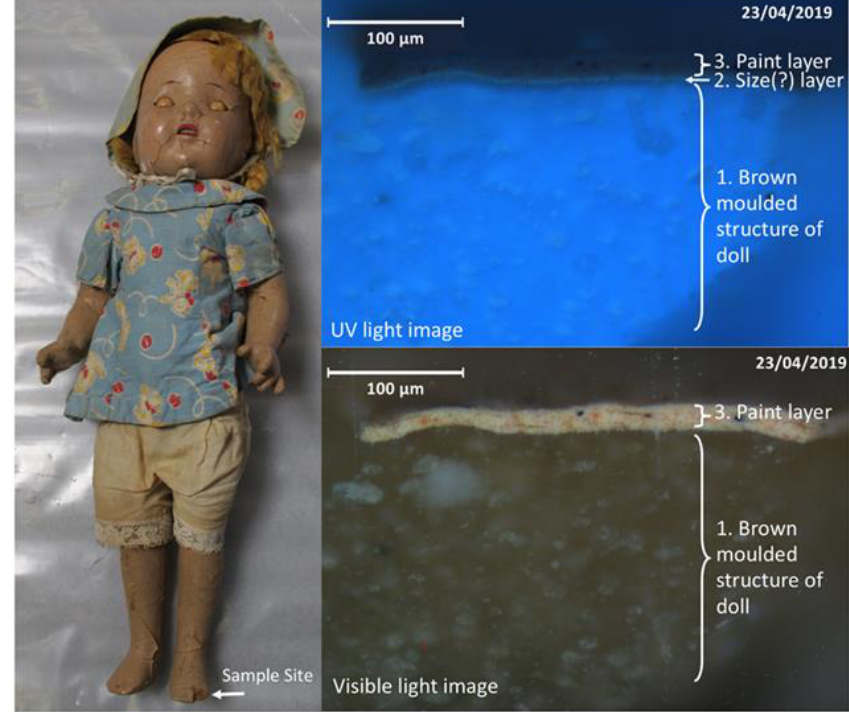
Figure 2. An example of one of the composition dolls (I10) with a severely cracked and delaminating nitrocellulose paint layer. Cross sections (shown in UV light and visible light) taken from a loss in the doll’s foot show three main layers: 1. the main structure of the doll comprised of brown moulded material 2. A green-white UV-fluorescent layer that could indicate a glue size layer (only visible in the UV cross section image) and 3. a single paint layer ~25 um thick. Image © Tate.